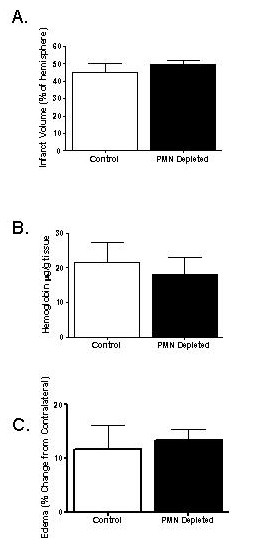
Infarct size, edema formation and hemoglobin excess differences between control and PMN-depleted animals. (A). Infarct size, as measured by TTC staining, indicated no differences between depletion and control groups. (B). Likewise, PMN depletion had no affect on the development of hemorrhagic transformation. (C) Edema determined as the difference in area between the ischemic and non-ischemic hemispheres was similar in neutrophil-depleted and control animals (n = 8 control, n = 10 PMN).